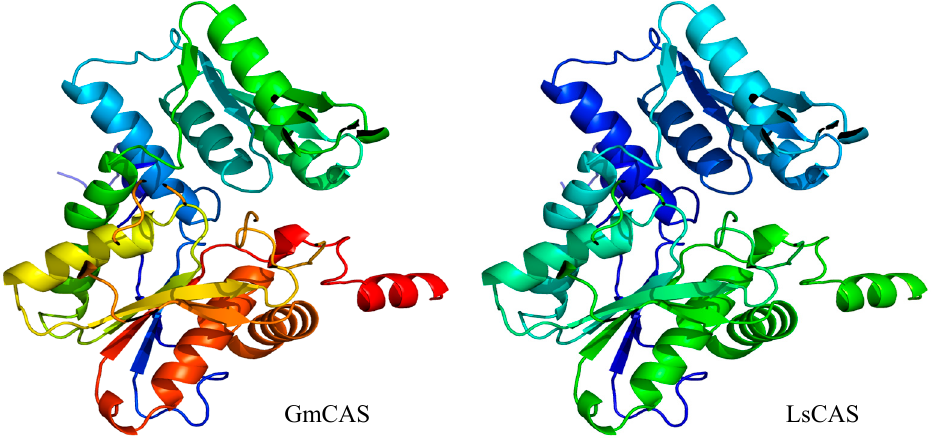
Figure 5. Homology-modeled structure of grass pea CAS. The 3-D structure of soybean [74] was used as a template to build a homology model of grass pea CAS using the Swiss-Model website (https://swissmodel.expasy.org) and viewed via Pymol.